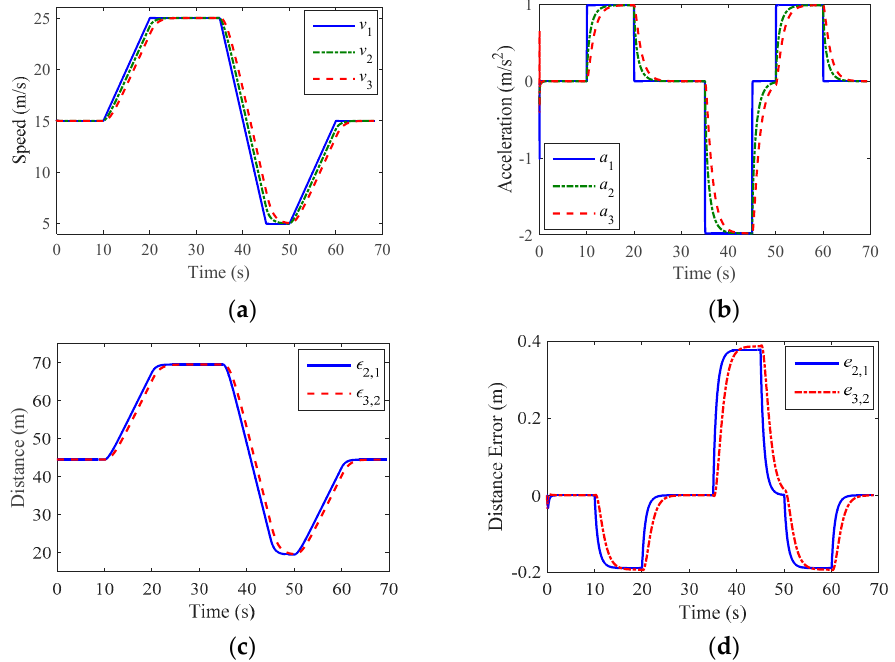
Figure 6. Vehicle platoon tracking performance in training conditions. ( a ) Vehicle speed v i (t) ( i = 1, 2, 3). ( b ) Vehicle acceleration a i ( t ) ( i = 1, 2, 3). ( c ) Inter-vehicle distance between consecutive vehicles ε i,i − 1 ( t ) ( i = 2, 3). ( d ) The distance error with the desired distance e i,i − 1 ( t ) ( i = 2, 3).